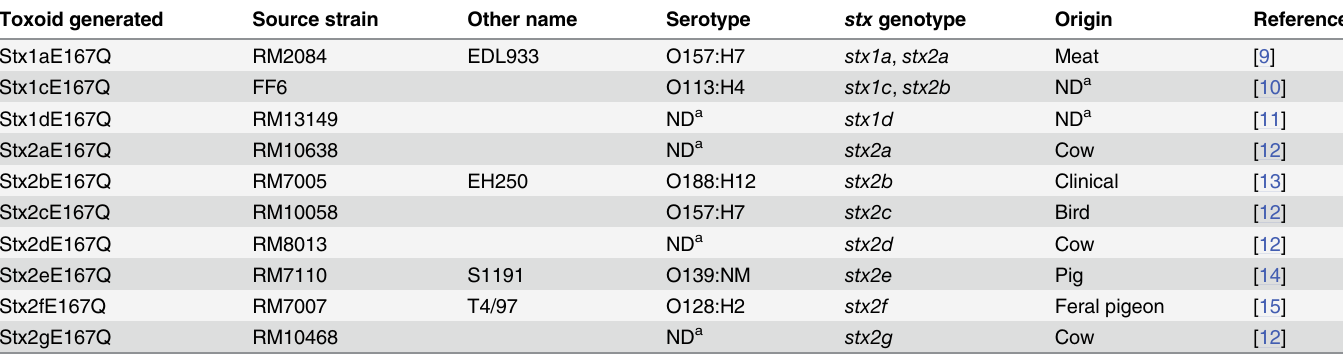
Table 1. Strains used to generate toxoids. Toxoid generated